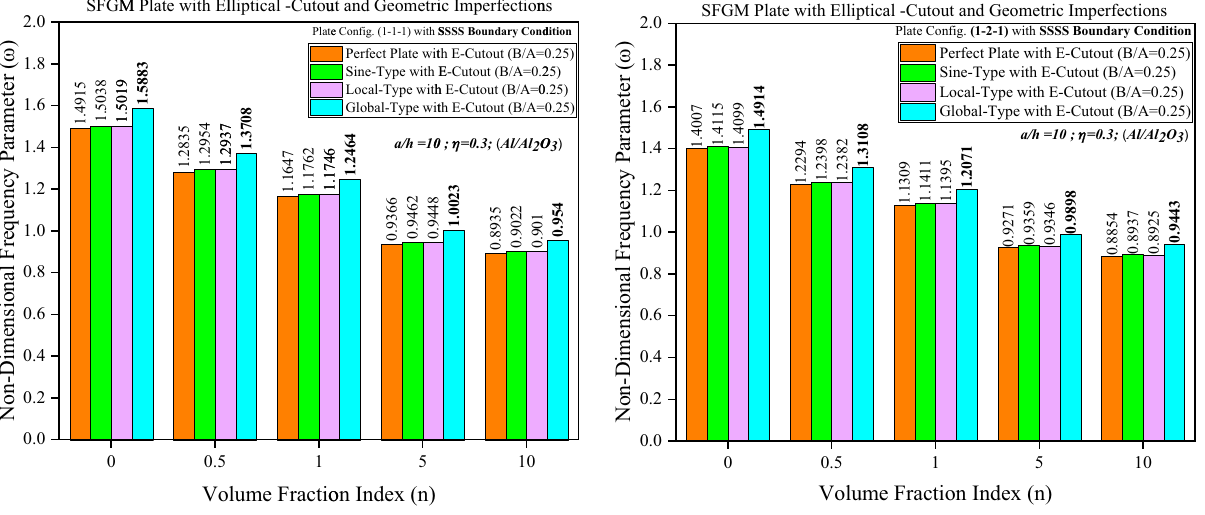
Figure 14: E ff ect of geometric imperfections and SSSS boundary condition on the NDFP of the SFGM plate with elliptical cutouts using ( 1 - 1 - 1 ) plate con fi guration with a / h = 10 and η = 0.3.